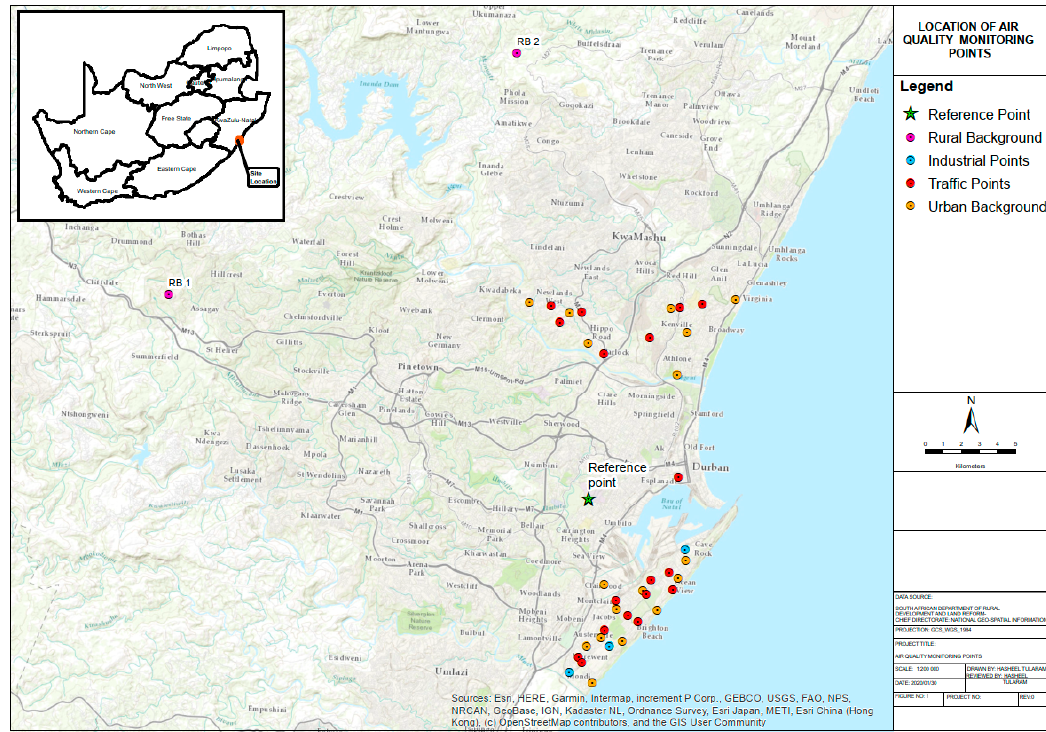
Figure 2. Location of air quality monitoring points in Durban north and Durban south, and their location within South Africa.